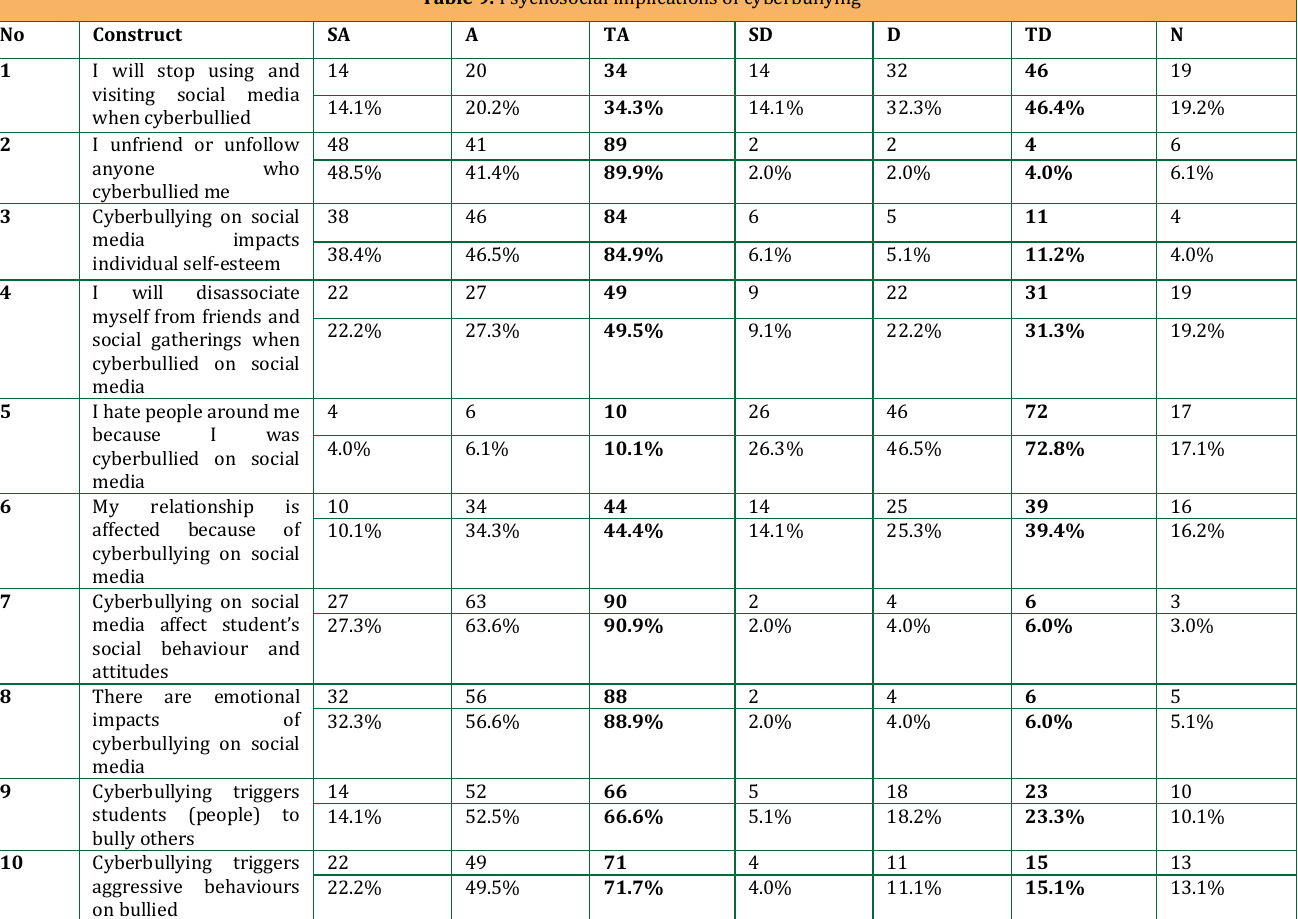
Table 9: Psychosocial implications of